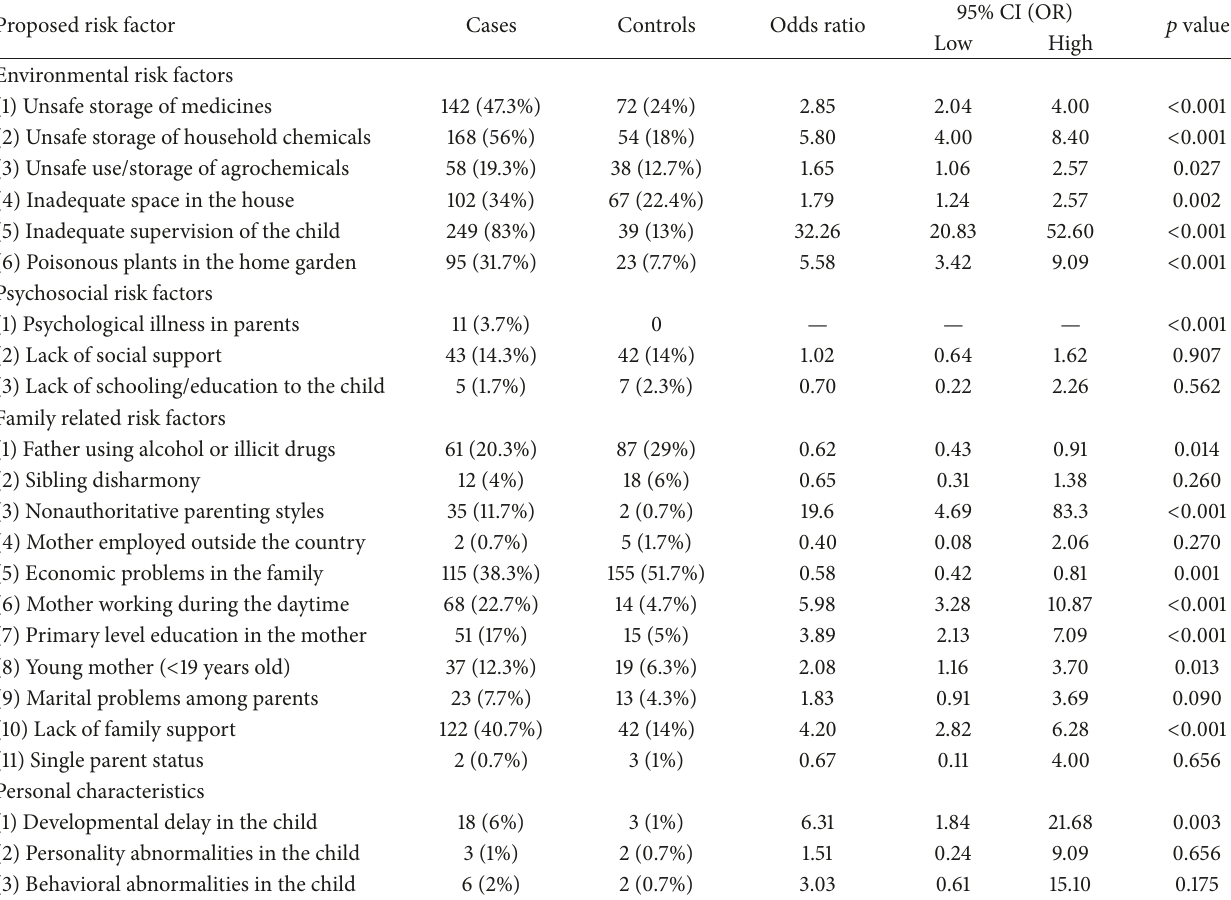
Table 4: Univariate unadjusted analysis of risk factors in the binary logistic regression model.